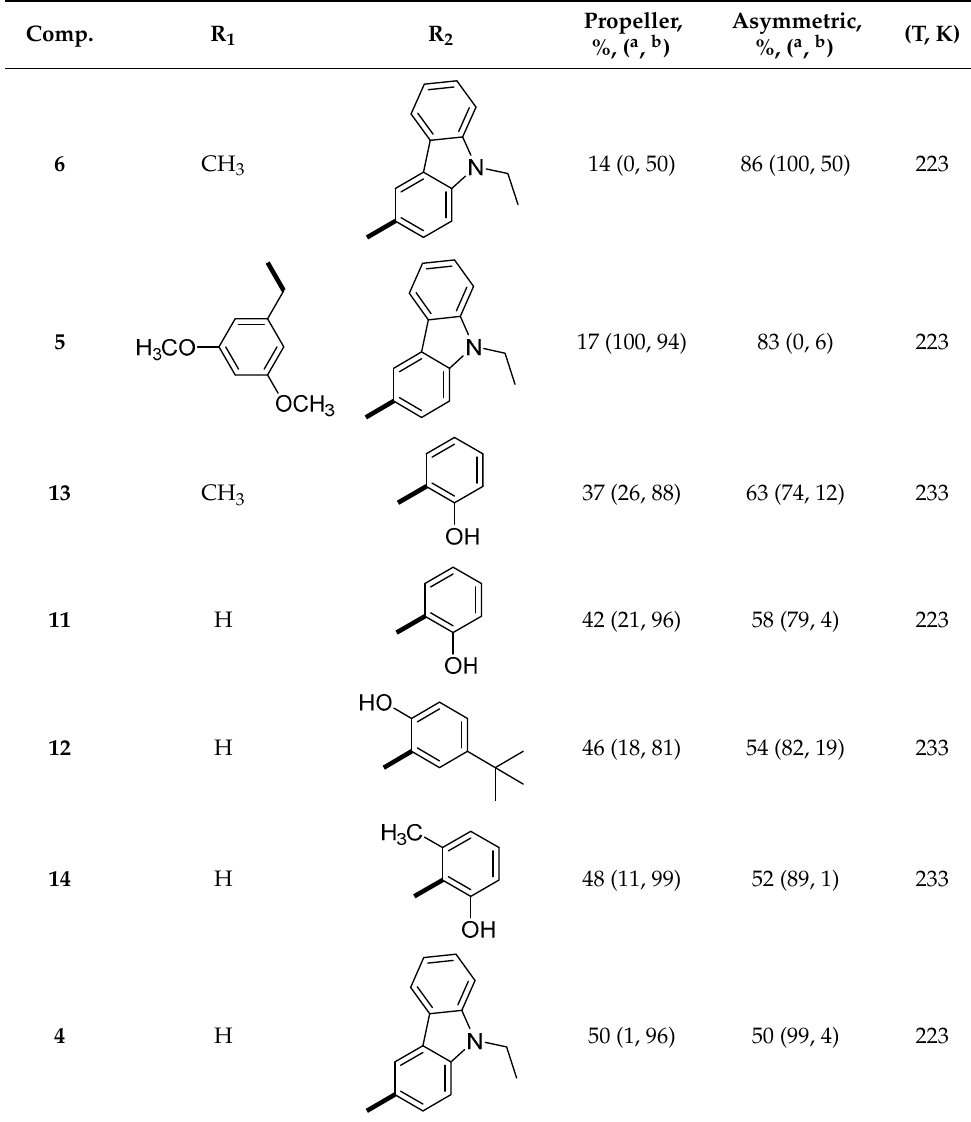
Table 3. Rotational barriers of propeller and asymmetric conformers in DMF-d7 of studied com- pounds.